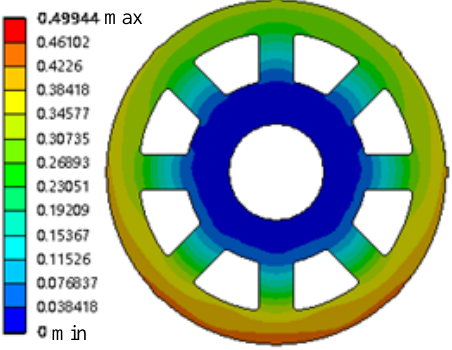
Figure 15. Strain distribution diagram of the rotor under the rated condition.